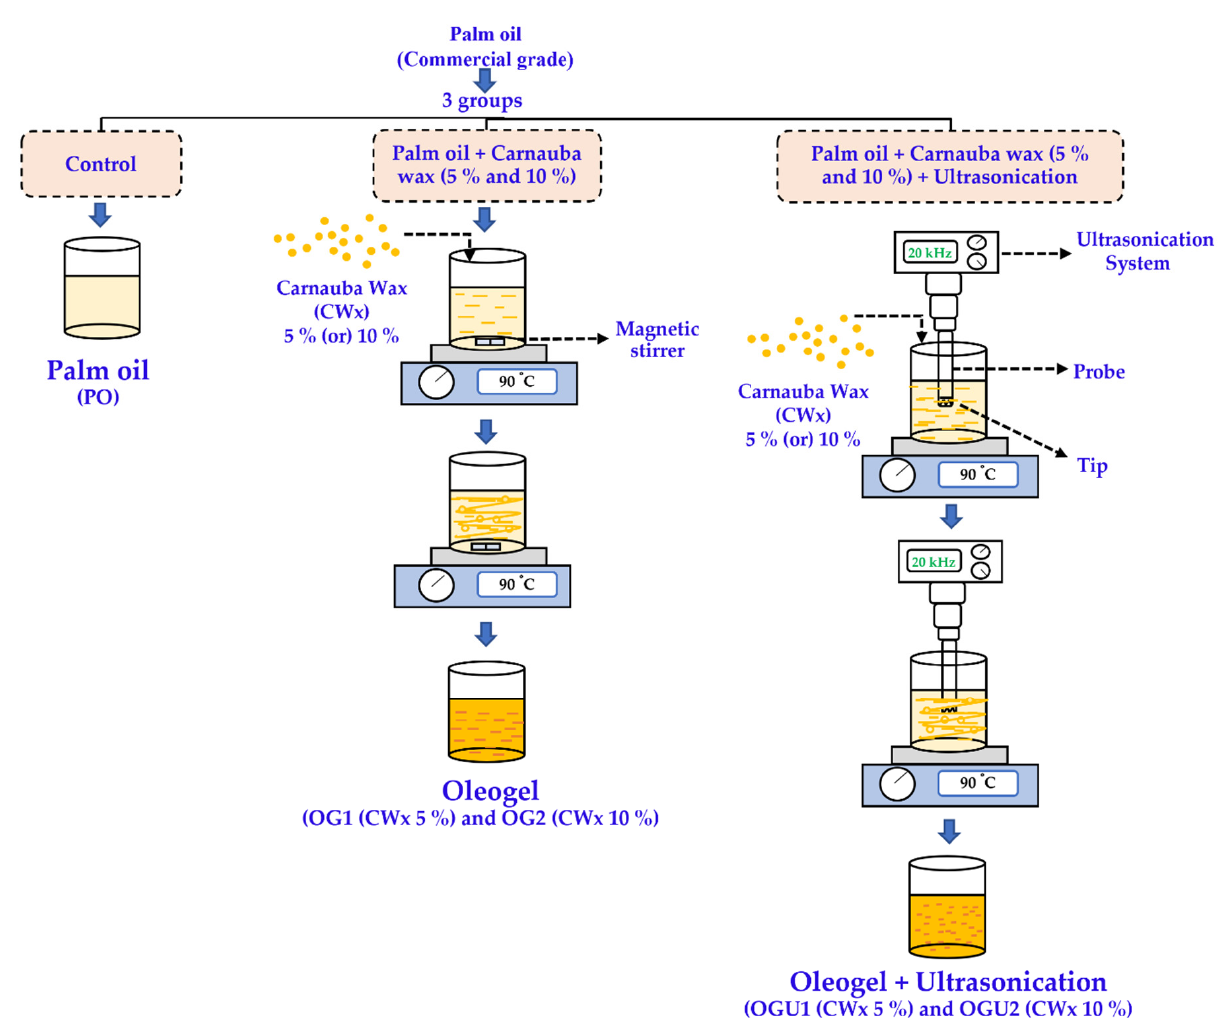
Figure 8. Pictorial reference of the preparation of the palm oil–carnauba wax oleogels and the ultrasonication assisted oleogels.